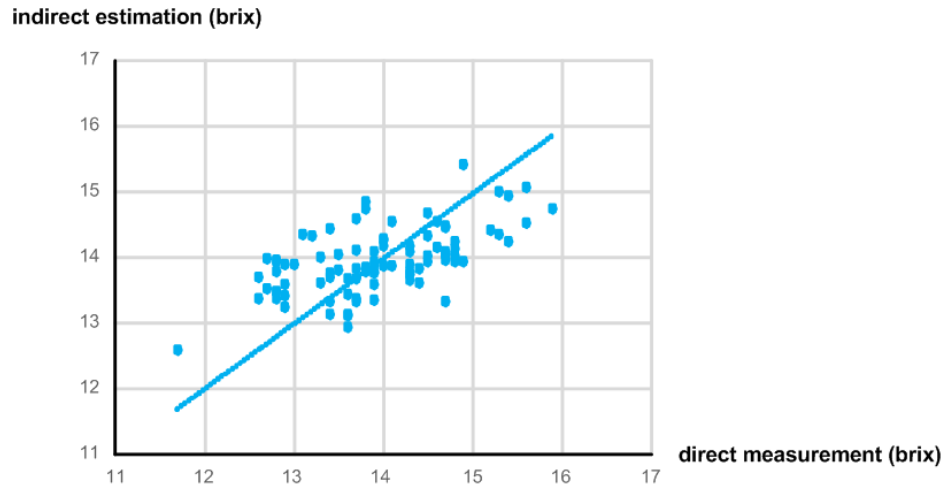
Figure 18. Correlation between indirect estimation and direct measurement of sugar content.